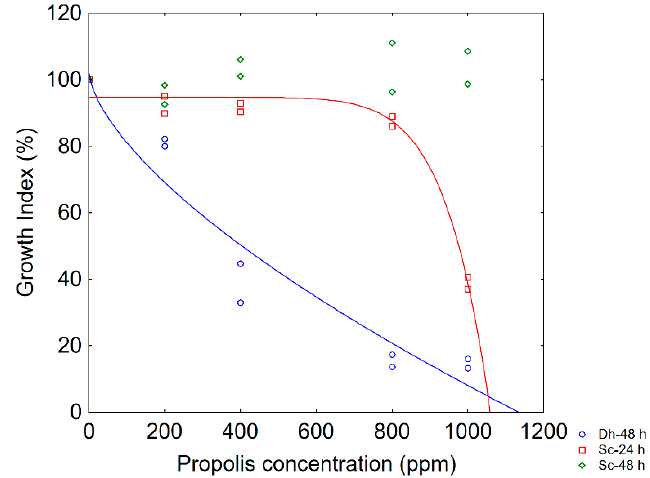
Figure 2. Dose response profile (Growth Index vs. propolis concentration) for yeasts after 24 or 48 h. The lines represent the best fitting of data through the Weibull model. S.c., S. cerevisiae ; D.h., D. hansenii . Micro-dilution approach for low-level inoculum (3 log cfu/mL).